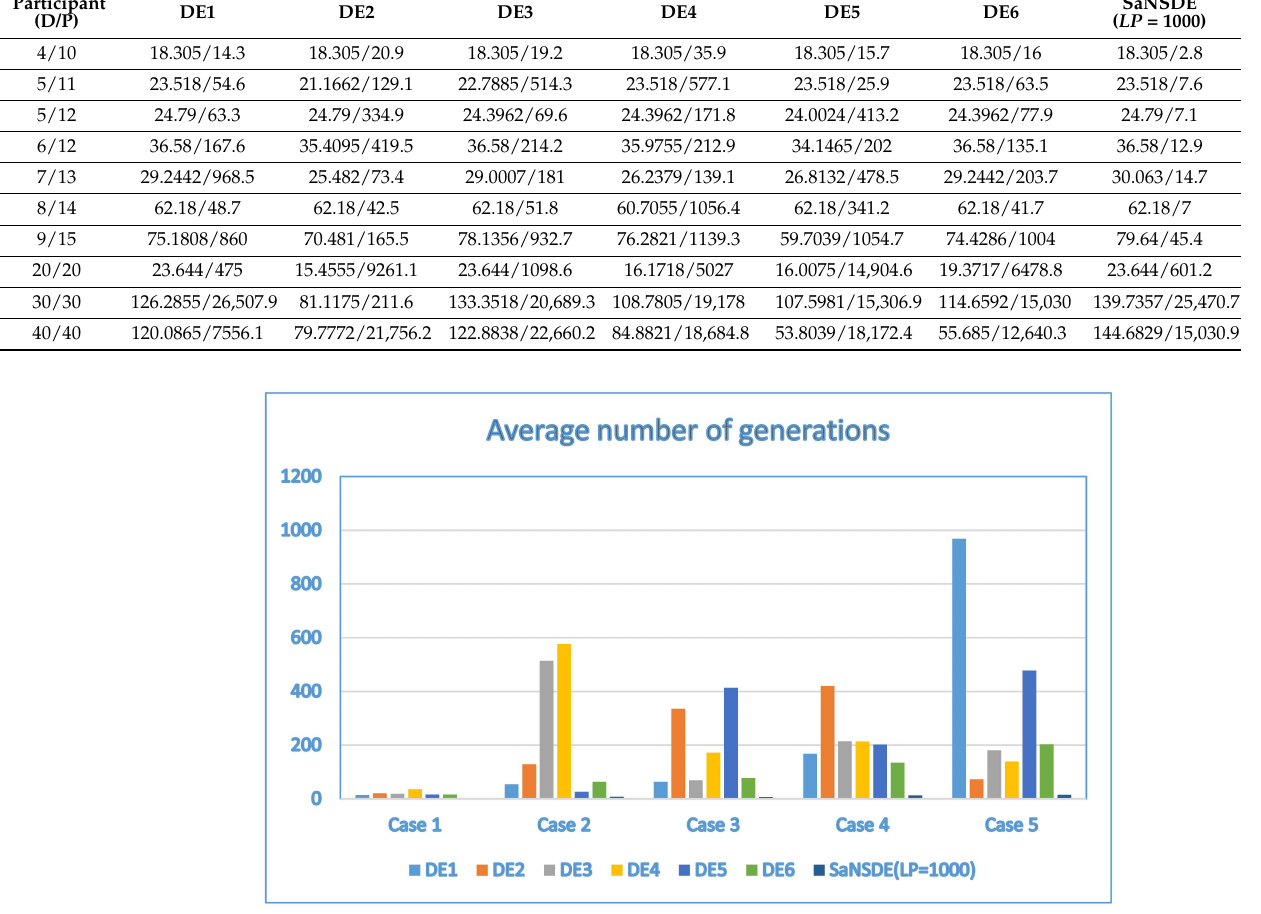
Figure 5. The average number of generations obtained by DE1, DE2, DE3, DE4, DE5, DE6 and SaNSDE with LP = 1000 for Case 1, Case 2, Case 3, Case 4 and Case 5.